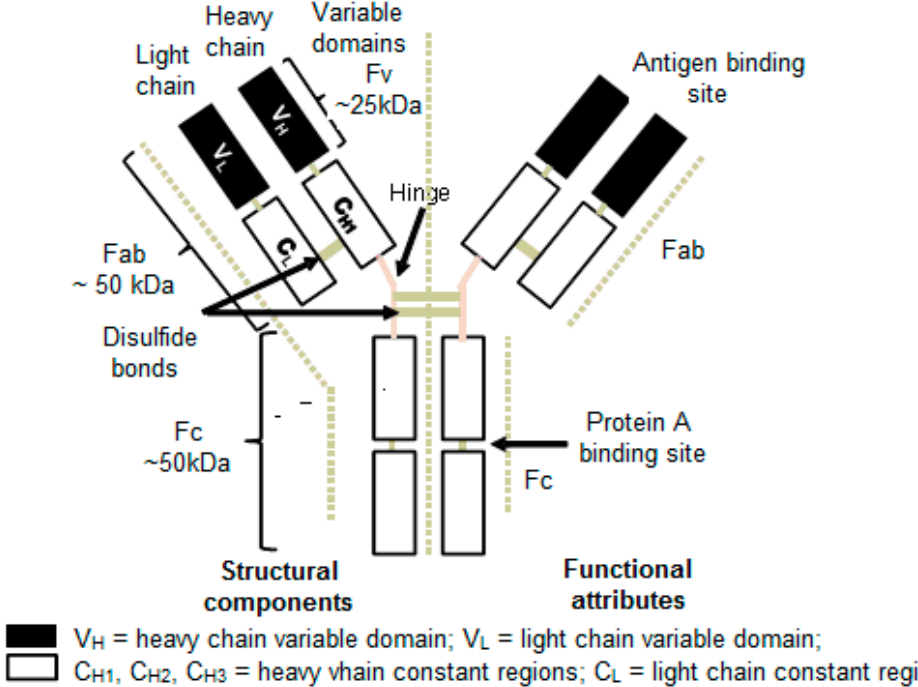
Figure 1. Structure of a Monoclonal Antibody (IgG).